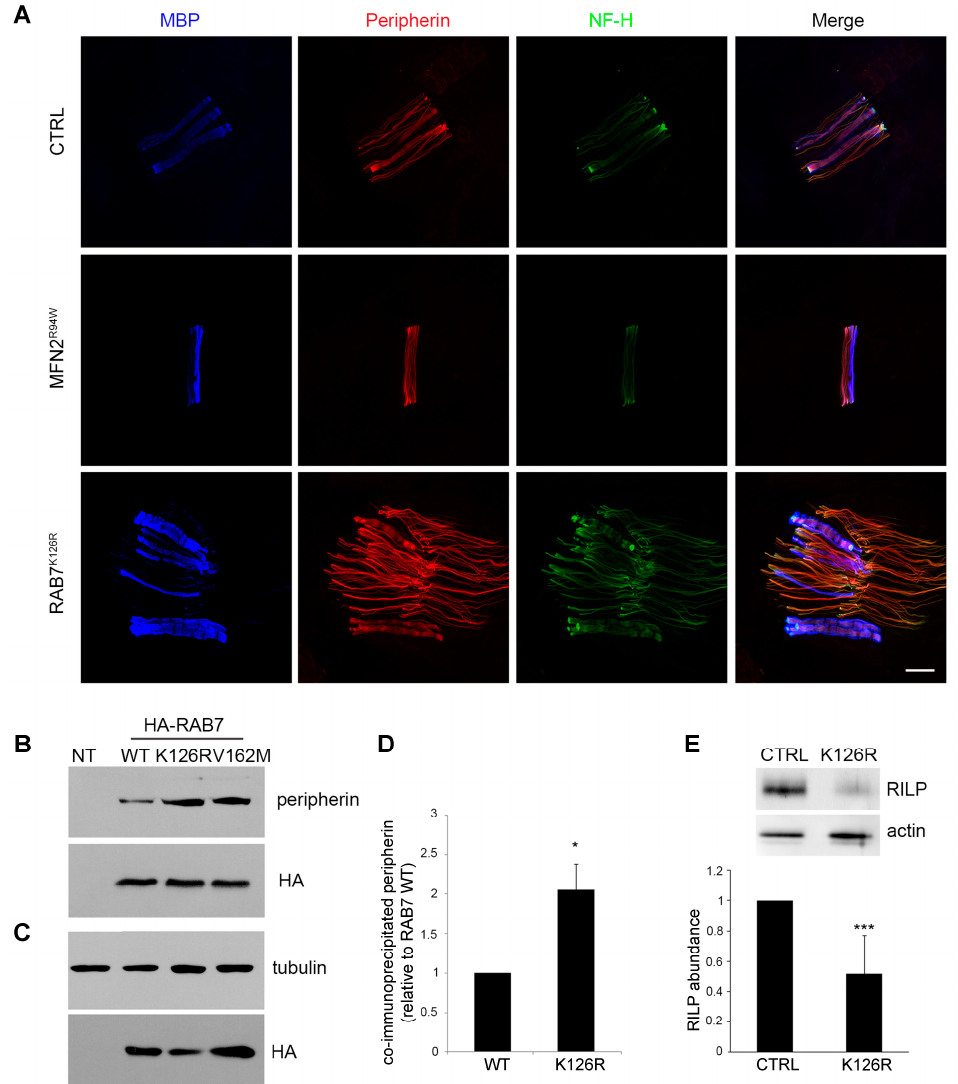
Figure 3. Analysis of two RAB7 interactors: peripherin and RAB-interacting lysosomal protein (RILP). ( A ) Immunohistochemical staining was performed on skin biopsy section using antibodies direct to peripherin, neurofilament-200, and MBP (myelinated nervous fibers) in the proband, in a patient with a mutation in MFN2 (axonal neuropathy), and in a healthy control. Scale bar = 20 μ m in all images. ( B ) HA-tagged RAB7 wt and mutant proteins were expressed in Neuro2A cells, as indicated, immunoprecipitated with an anti-HA antibody and subjected to WB using anti-peripherin and anti-HA antibodies. ( C ) Total extracts of Neuro2A cells, overexpressing the indicated proteins, were analyzed using anti-HA and anti-tubulin antibody to evaluate expression levels of the proteins. ( D ) Quantification of immunoprecipitated peripherin. Values are the mean of three independent experiments ± s.e.m.. The intensities were quantified by densitometry, normalized against the amount of RAB7 wt or RAB7 K126R , and plotted as a percentage of the intensities obtained using RAB7 wt (set to 1). Data were analyzed statistically using Student’s t-test. Values of cells expressing RAB7 K126R were found to be significantly different from the values of cells expressing RAB7 wt (* p < 0.05). ( E ) Lysates of the sural nerve from a healthy individual (CTRL) and proband carrying the RAB7 K126R mutation were analyzed by immunoblotting using anti-RILP and anti-actin antibodies. The intensities of the RILP bands were quantified using Gene Tools from Syngene and normalized against actin. The intensity of the RILP band in CTRL cells has been set to 1. Data represent the mean ± s.e.m. of six independent experiments. Statistical analysis was performed using Student’s t-test. *** p <